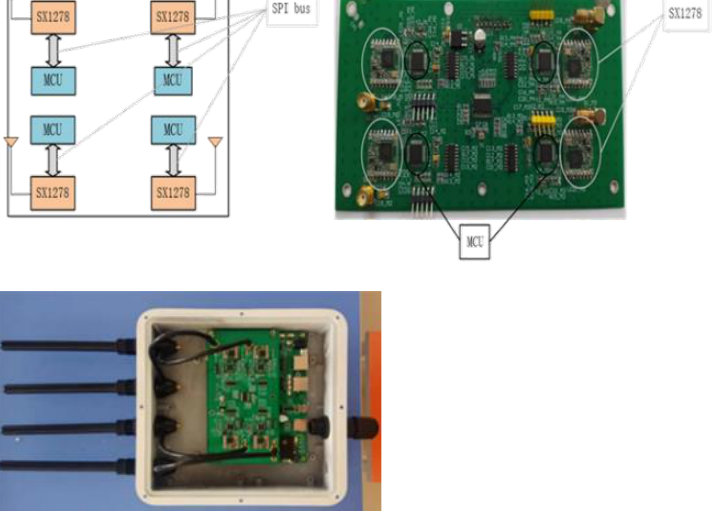
Figure 8. Gateway hardware design.